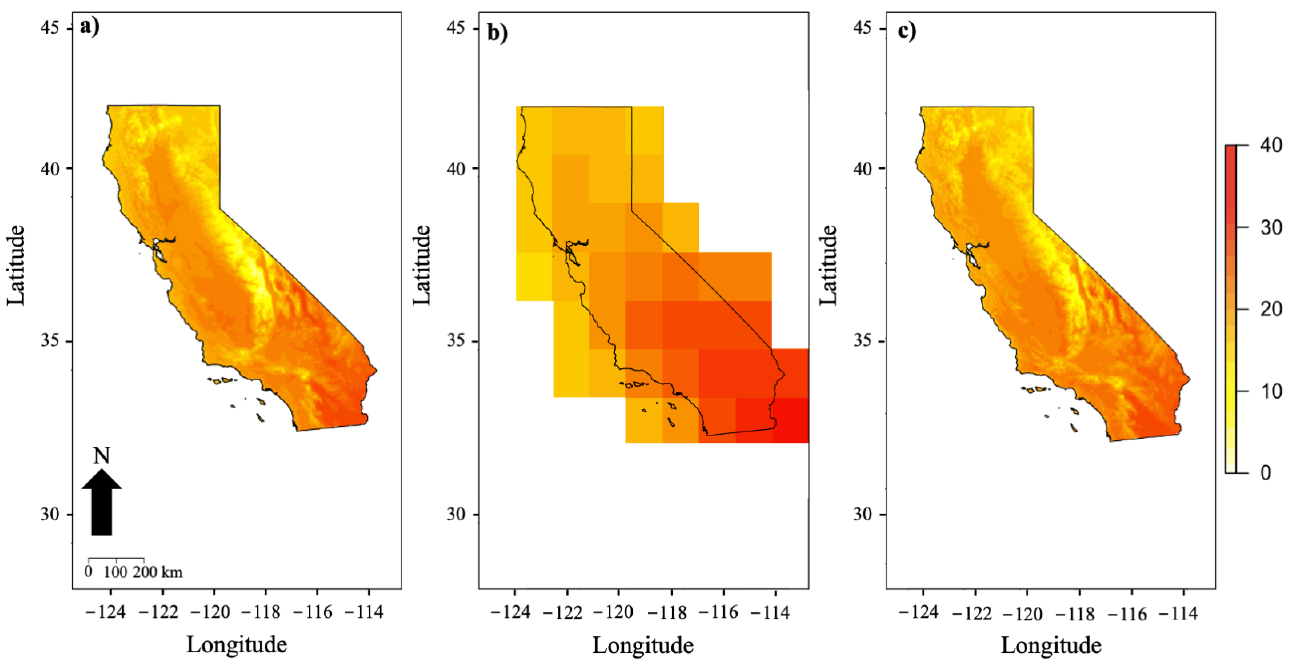
Figure 2. Average maximum temperature for 1979 ( a ) TerraClimate ( b ) Raw MIROC6 ( c ) BCSD Ensemble. Units: °C.